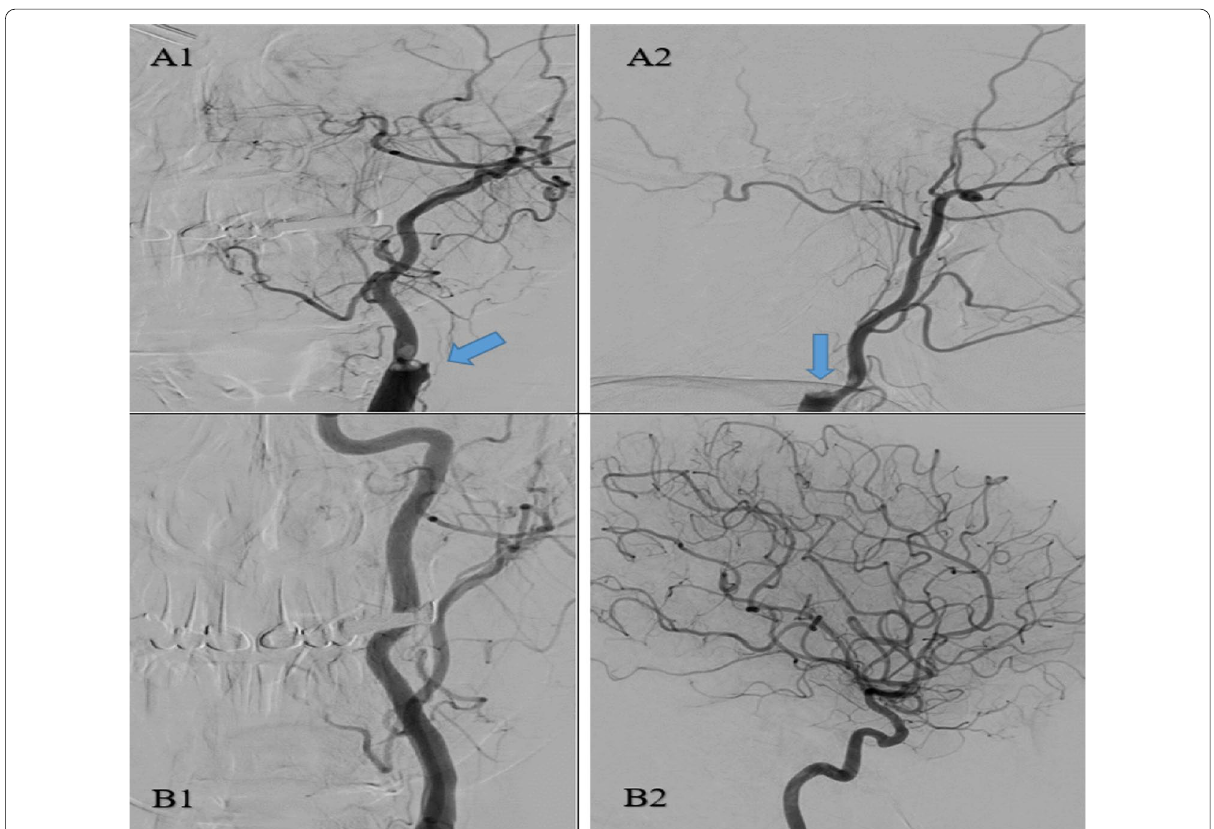
Fig. 4 A 53 years‑old‑woman with atrial fibrillation that developed postoperative acute right‑sided hemiparesis. Left carotid angiogram showed a filling defect (consistent with an embolic clot) completely occluding the internal carotid artery and partially occluding the origin of external carotid artery ( A1 & A2 ). Complete recanalization of both internal and external carotid arteries was achieved after mechanical thrombectomy ( B1 & B2